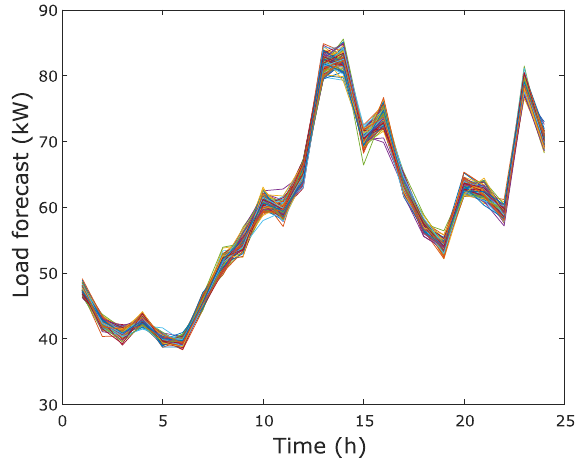
Figure 4. Load forecast for 24 h.